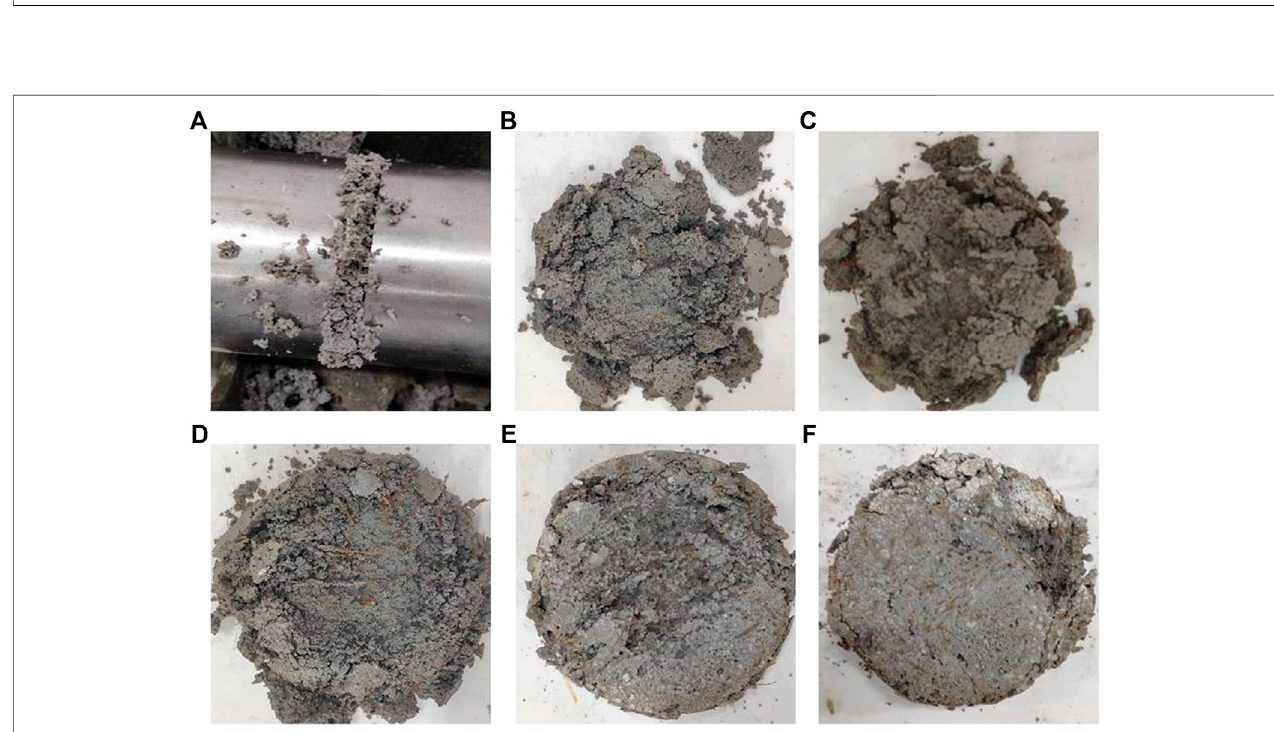
FIGURE5| Failuremodesatthegaspressureof0.25 MPa (A) CF0.0-AP0.25-2 (B) CF0.5-AP0.25-3 (C) CF1.0-AP0.25-3 (D) CF1.5-AP0.25-1 (E) CF2.0-AP0.25- 3 (F) CF2.5-AP0.25-1.